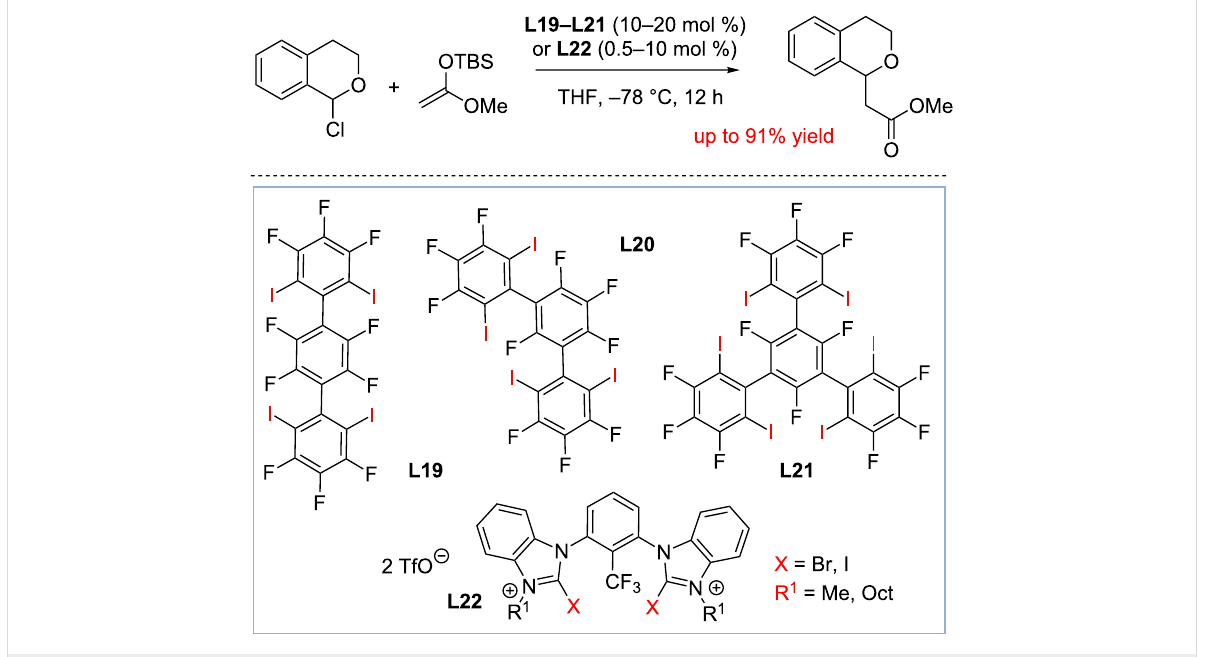
Scheme 17: Halogen bond-donor-catalyzed addition to oxocarbenium ions by Huber and co-workers [89].